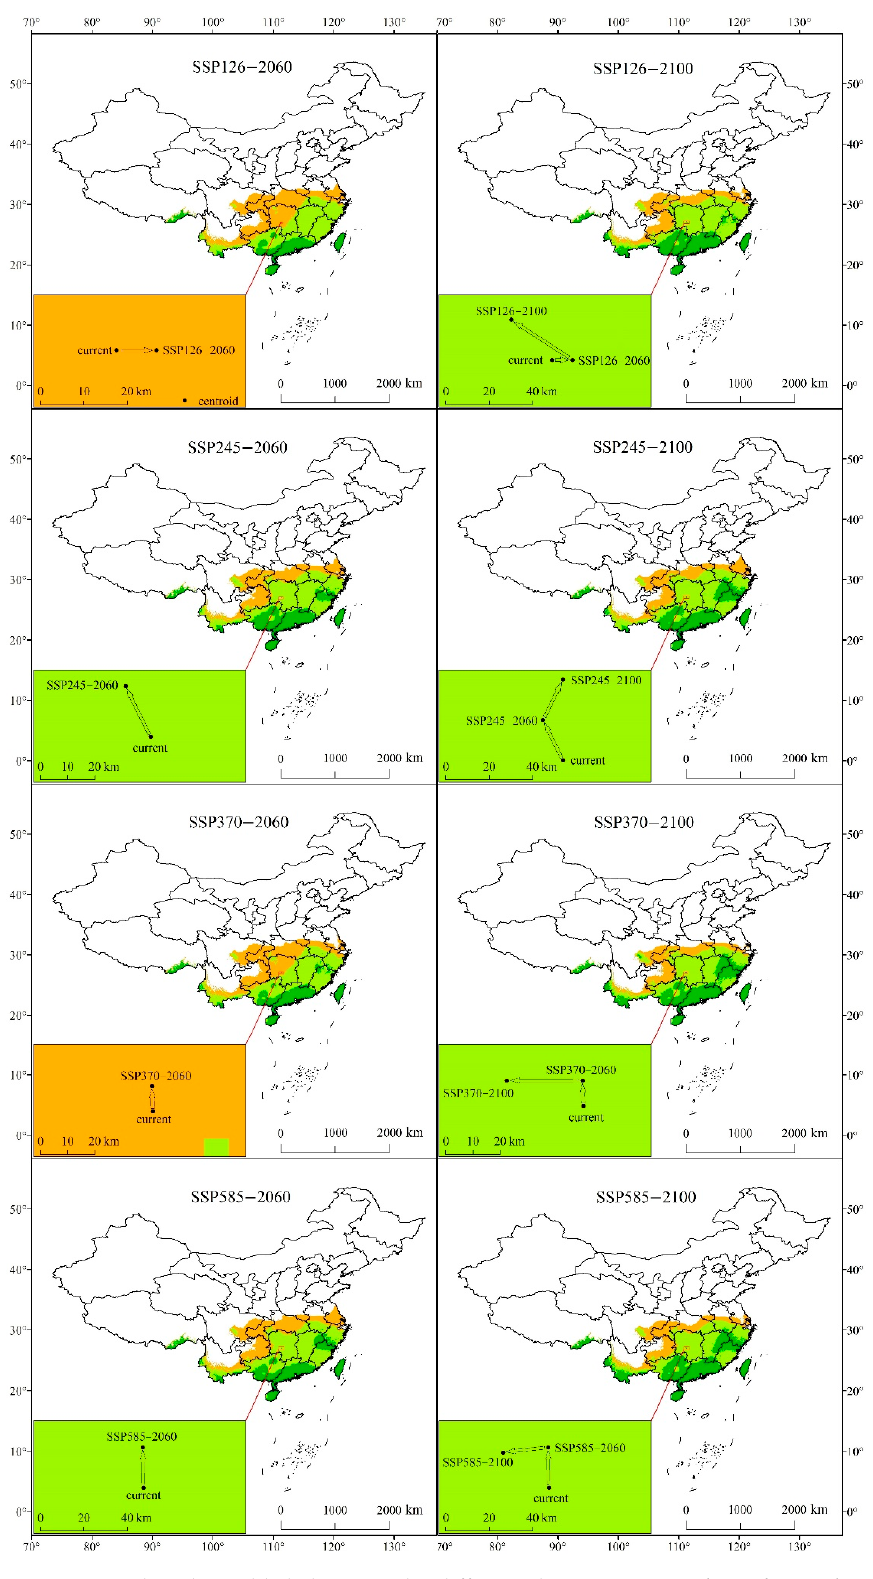
Figure 4. Predicted suitable habitats under different climate scenarios/year for C. glauca . The black dot indicates the centroid, and the arrow indicates the magnitude and direction of the predicted change trough time. Orange refers to marginally suitable habitat; light green refers to moderately suitable habitat; dark green refers to highly suitable habitat; blank refers to not suitable